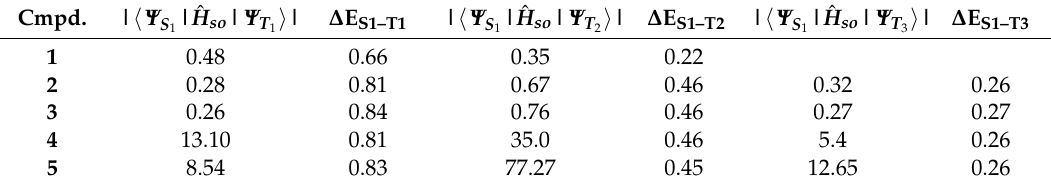
Table 2. Spin–orbit matrix elements (cm −1 ) and singlet-triplet energy gaps (eV) calculated at the B3LYP/cc-pVDZ level of theory.